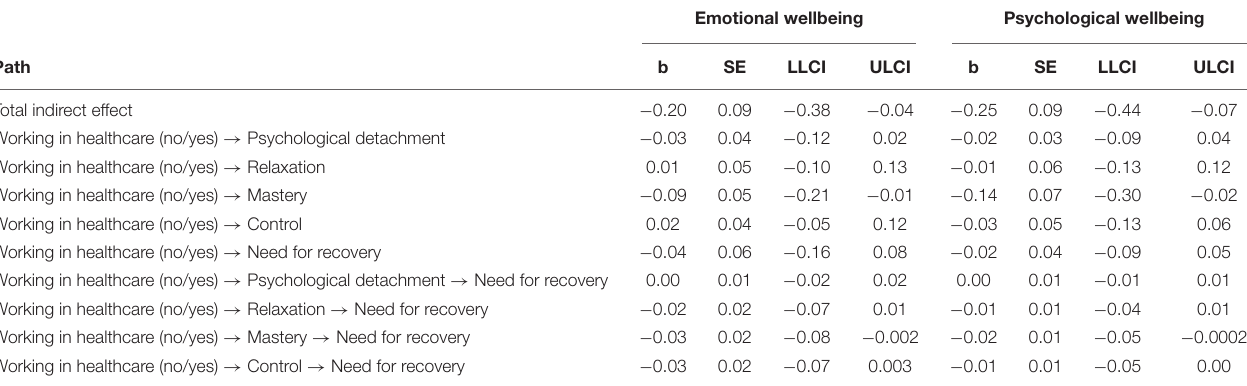
TABLE 3 | Total and individual indirect effects of working in healthcare on emotional and psychological wellbeing through work recovery experiences and need for recovery ( N =